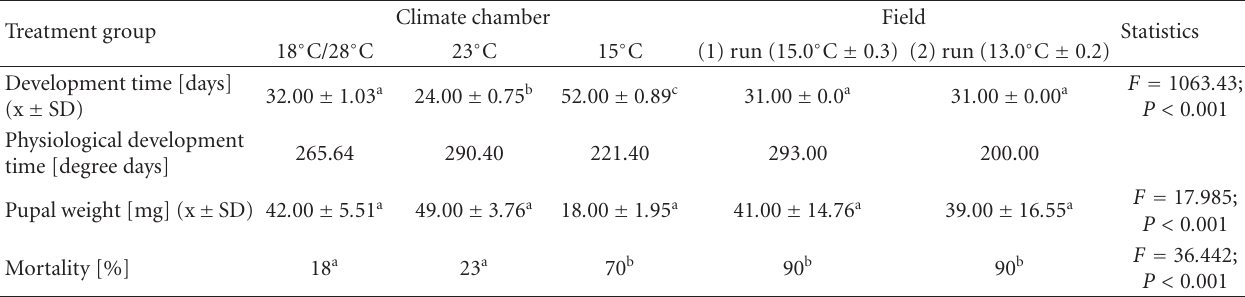
Table 1: Comparison of larval development of the di ff erent treatment groups in the climate chambers and in the field with a statistics column, showing the di ff erences between all groups. Di ff erent letters indicate significant di ff erences between treatment groups, shown with development time, weight, and mortality.